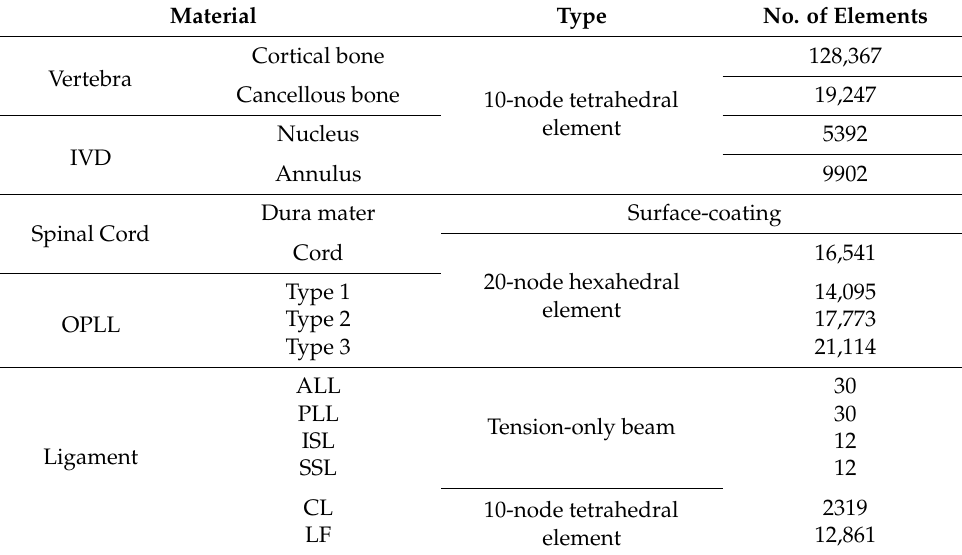
Table 3. Type and number of elements on finite element